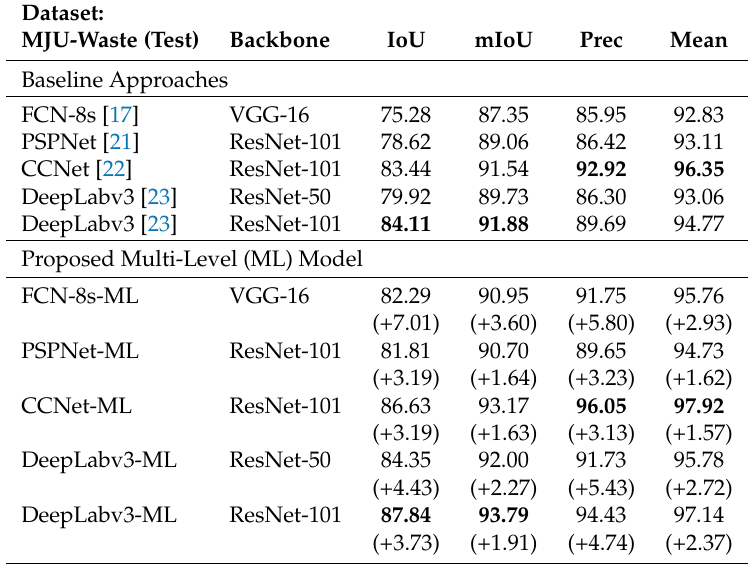
Table 3. Performance comparisons on the test set of MJU-Waste. For each method, we report the IoU for waste objects (IoU), mean IoU (mIoU), pixel Precision for waste objects (Prec) and Mean pixel precision (Mean). See Section 4.3 for